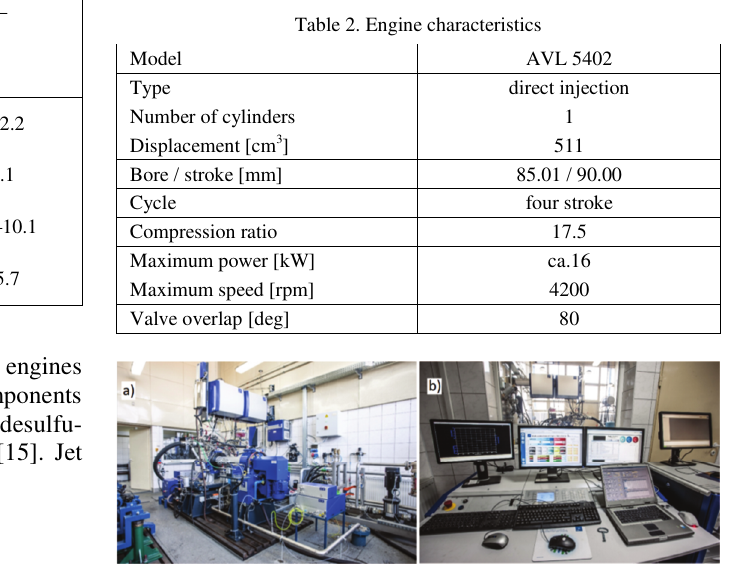
Fig. 2. AVL test bed: (a) general view of the test bed, (b) view of the control